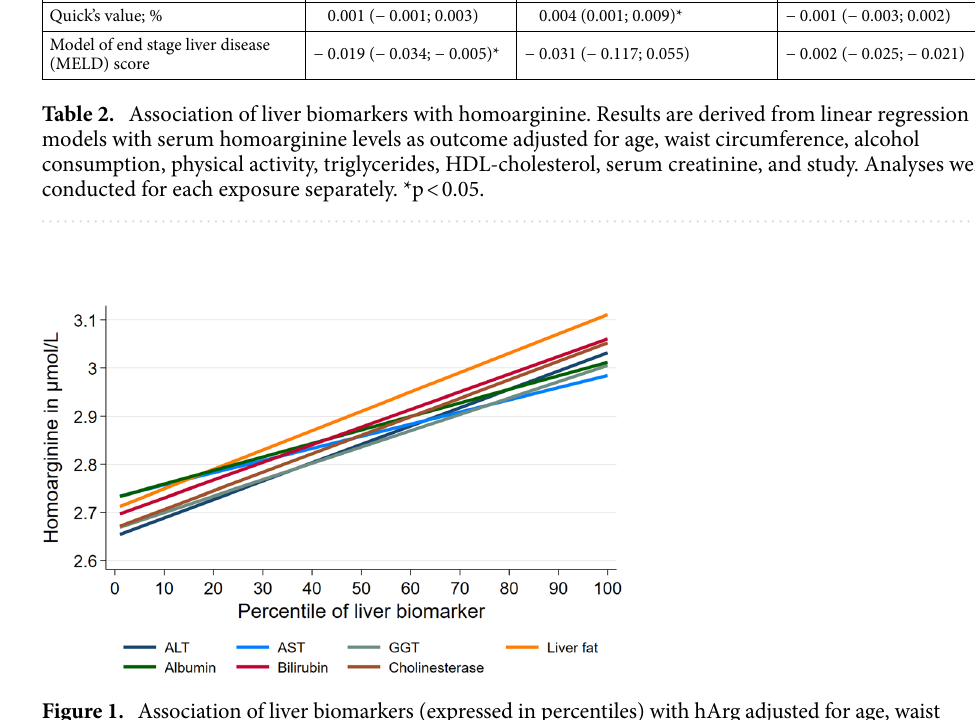
Figure 1. Association of liver biomarkers (expressed in percentiles) with hArg adjusted for age, waist circumference, alcohol consumption, physical activity, triglycerides, HDL-cholesterol, serum creatinine, and study in males.